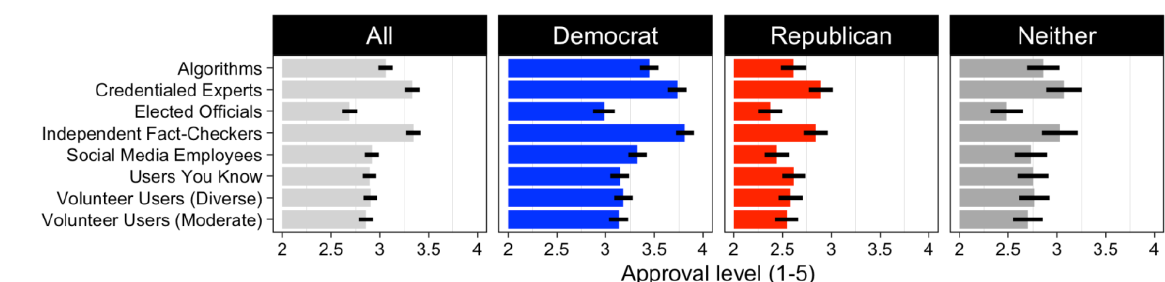
Figure 6. Mean approval for different intervention sources (“decision - makers”) by party. This plot shows mean approval levels ±1.96 standard errors (using the same scale as in Figure 4) within various groups (panels) of different intervention sources or “decision - makers” ( y -axis) for label / removing posts on social media.